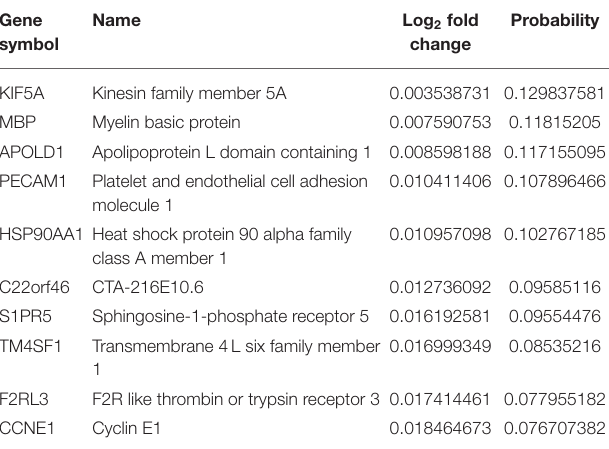
TABLE 5 | The top 10 upregulated genes in asymptomatic AD vs. control samples.